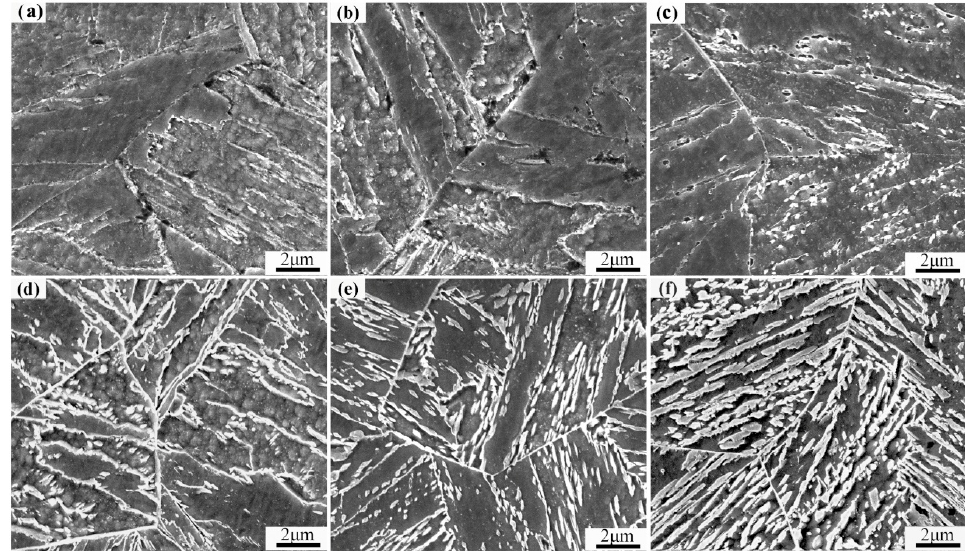
Figure 2. SEM microstructure of the samples tempered at 580 °C for different time ( a ) 1 h, ( b ) 2 h, ( c ) 4 h, ( d ) 8 h, ( e ) 16 h and ( f ) 32 h.